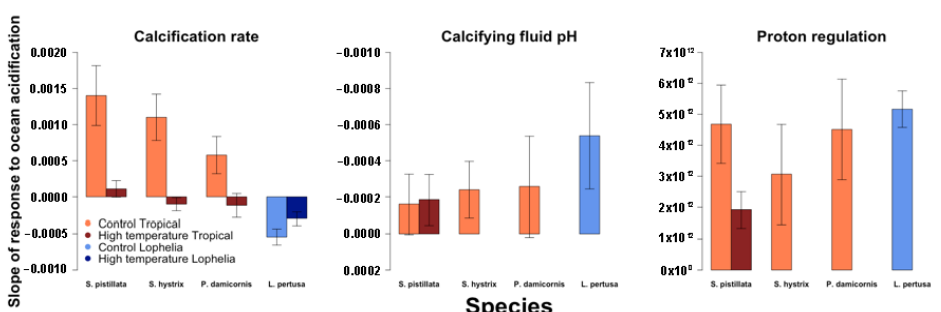
Figure 5. Slopes of regressions calculated from linear mixed effects models investigating the impacts of pCO 2 and temperature on calcification rate, calcifying fluid pH, and Δ[H + ]. Significant differences were found amongst the slopes of the different coral species’ calcification responses to ocean acidification and warming. No significant difference was observed amongst the slopes of the different coral species’ calcifying fluid pH response to ocean acidification. The slopes of the different coral species’ proton regulation response (i.e., Δ[H + ]) to ocean acidification were not significantly different from each other. Vertical bars represent 95% confidence intervals.